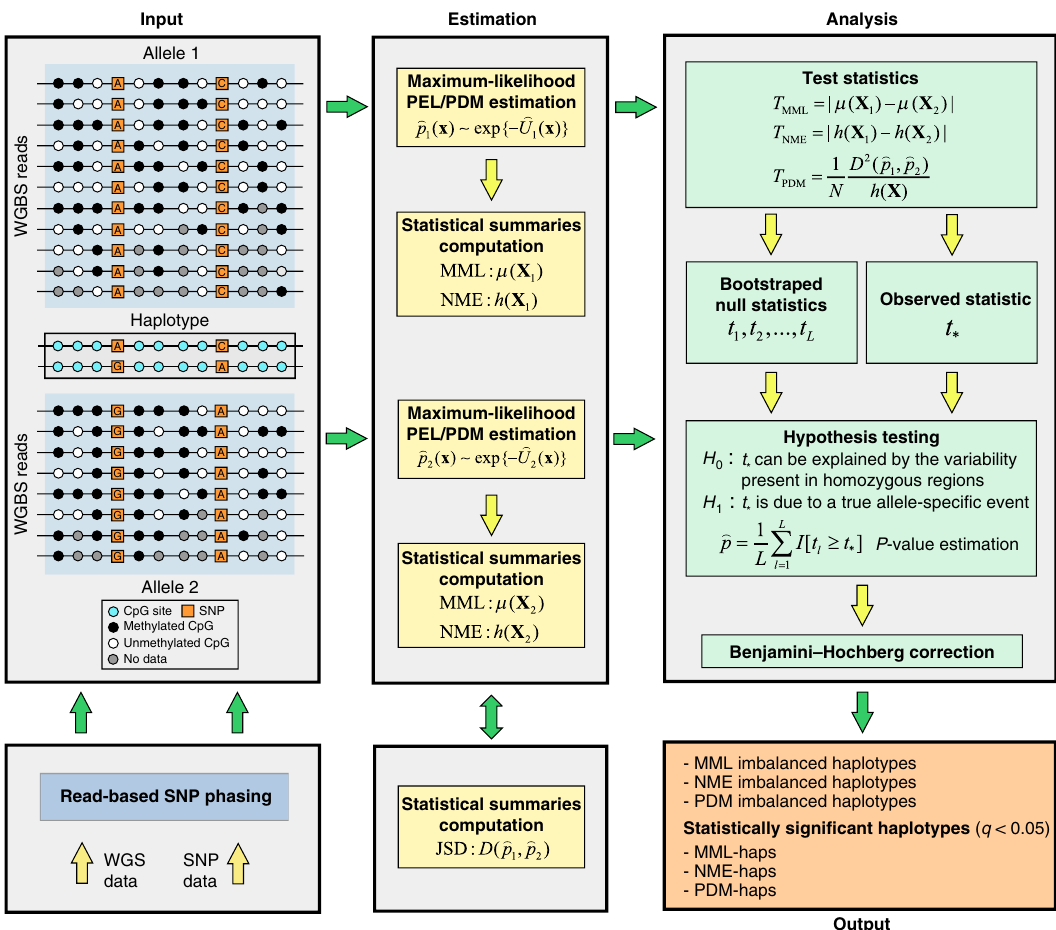
Fig. 2 Flowchart illustration of the CPEL method. The CPEL method fi rst requires genome-wide identi fi cation of haplotypes, performed via read-based SNP phasing using WGS and SNP data, followed by mapping WGBS methylation reads to the homologous alleles of each haplotype according to their allele of origin. Using the WGBS data assigned to each allele, the CPEL method then computes a maximum-likelihood estimate b U ð x Þ of the potential energy landscape (PEL) of the methylation state x , given by Eq. (2), determines a PDM estimate b p ð x Þ (cid:2) exp f(cid:3) b U ð x Þg , and summarizes methylation stochasticity